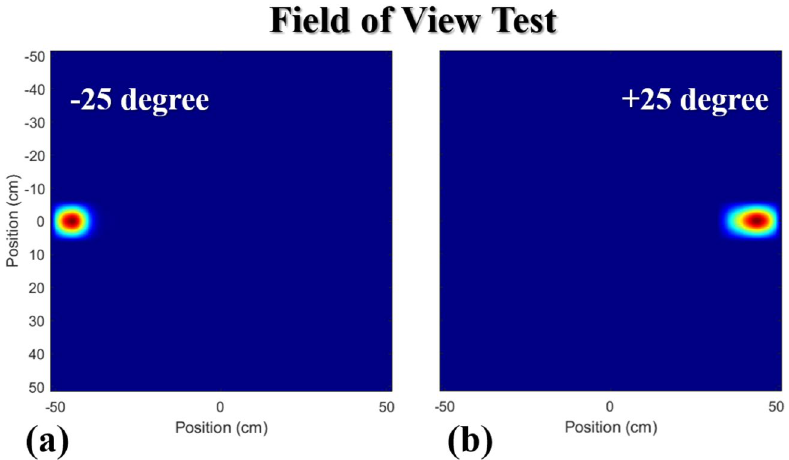
Figure 9. Field of view ( FOV ) tests for the coded-aperture DPI system when a 137 Cs source of 0.312 MBq located at an angle of − 25° ( a ), and at + 25° ( b ) at 100 cm distance. Both reconstructed images are obtained using the gamma-ray events above the 50 keVee.